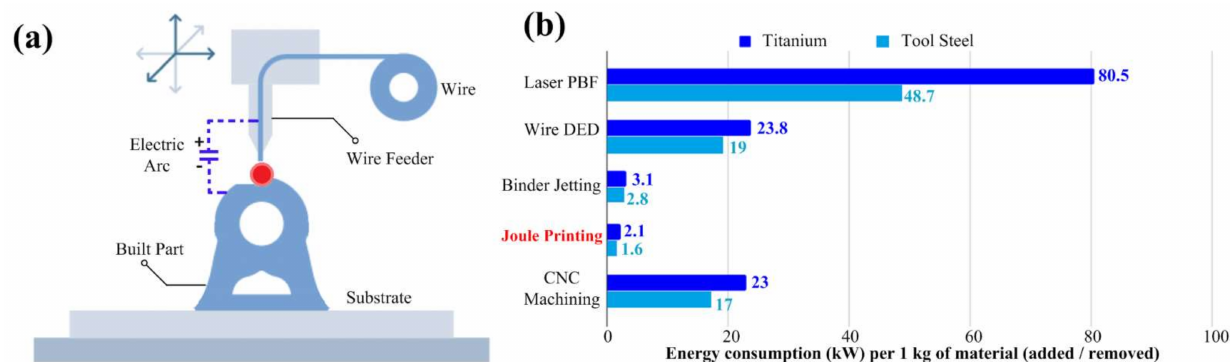
Figure 5. Joule Printing: ( a ) The concept; ( b ) Energy consumption compared to other methods